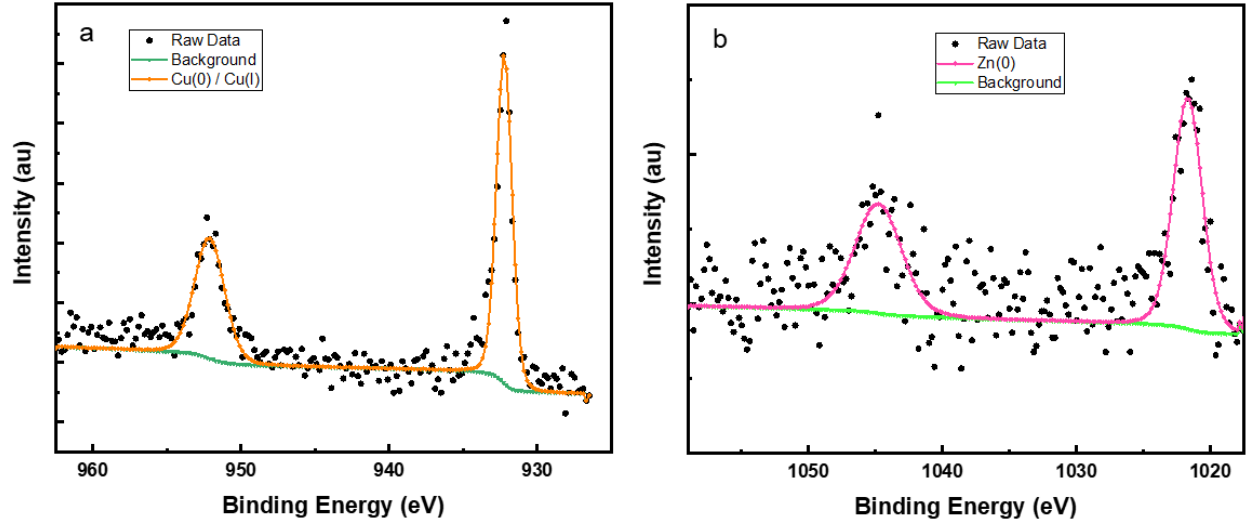
Figure 13. ( a ) Cu 2p and ( b ) Zn 2p XPS spectra of P2T treated brass sample.